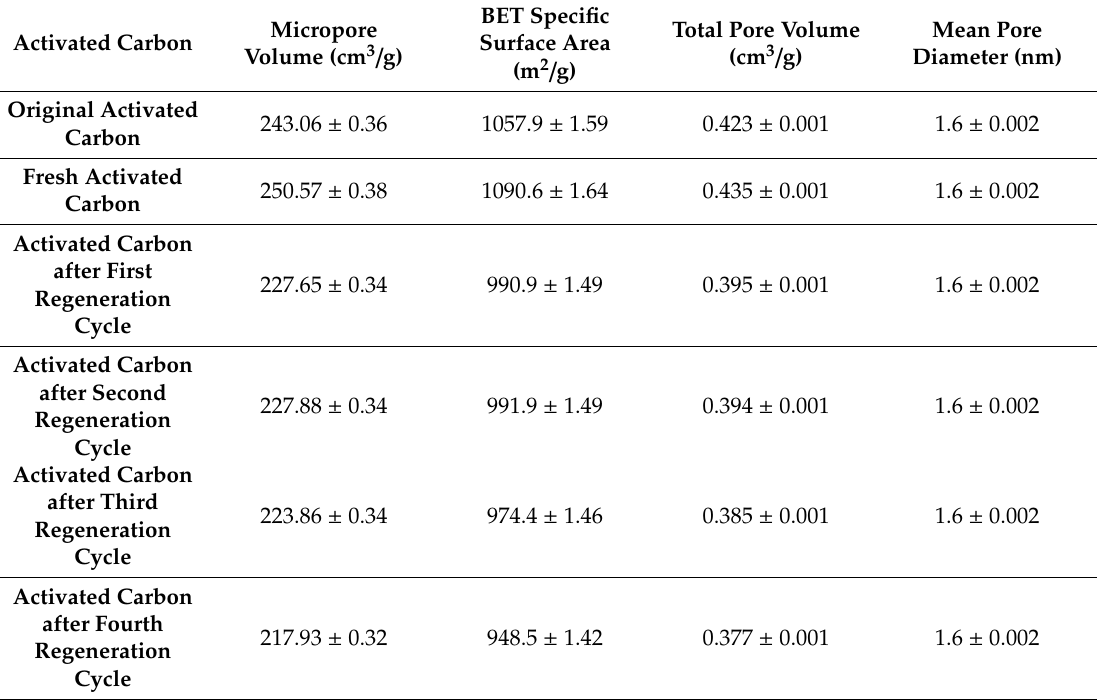
Table 2. Pore structure characteristics of original, fresh and ultrasound-regenerated activated